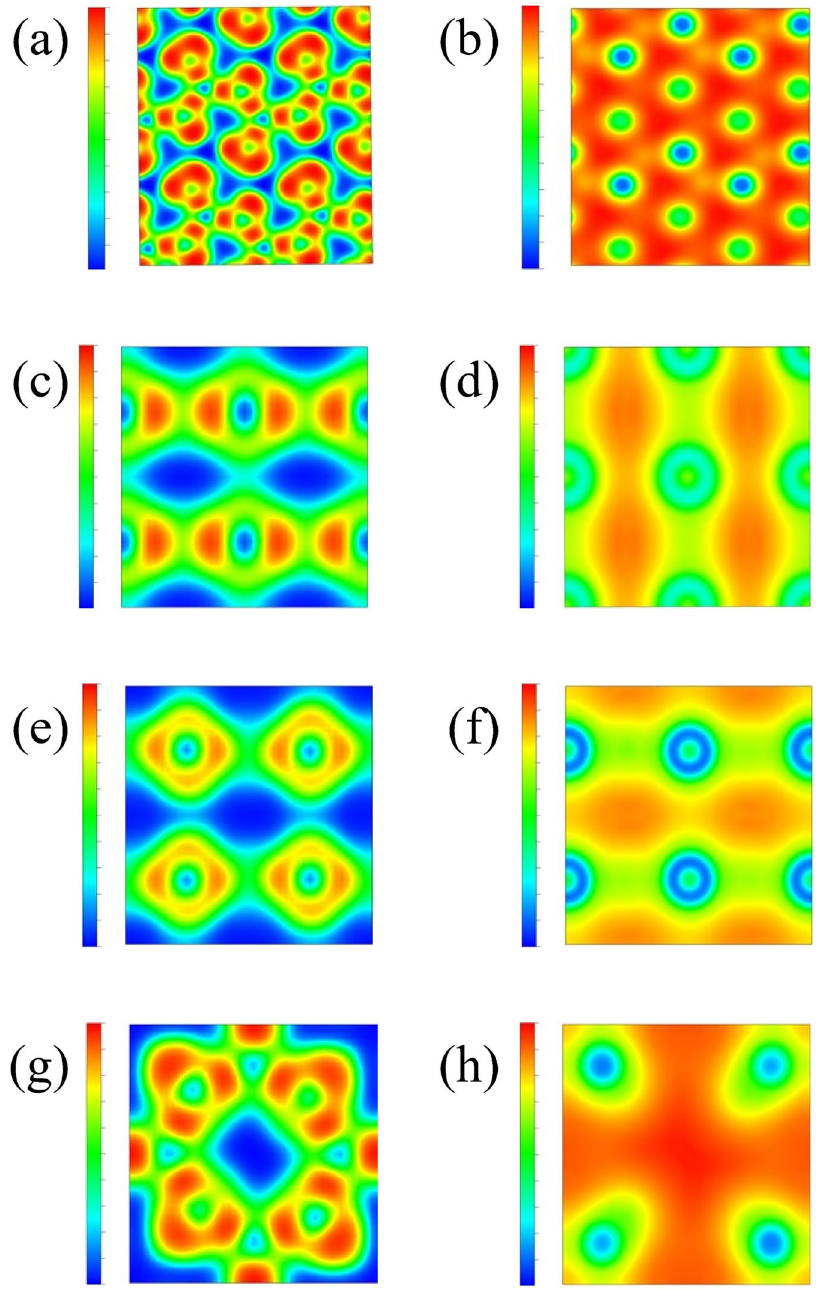
Fig. 9 Electronic level insight into ultrahigh hardness. The ELF and LOCPOT plot of the structure B 4 C 8 N 4 (mp-1079201) ( a , b ), BC 7 (mp- 1078935) ( c , d ) recommended by BLOX showing the presence of more electrons and covalent bonding. e – h The ELF and LOCPOT plot of two identi fi ed structures Be 4 C 8 N 4 (mp-1189451) and C 12 N 8 (mp-1188347) showing the presence of strong covalent